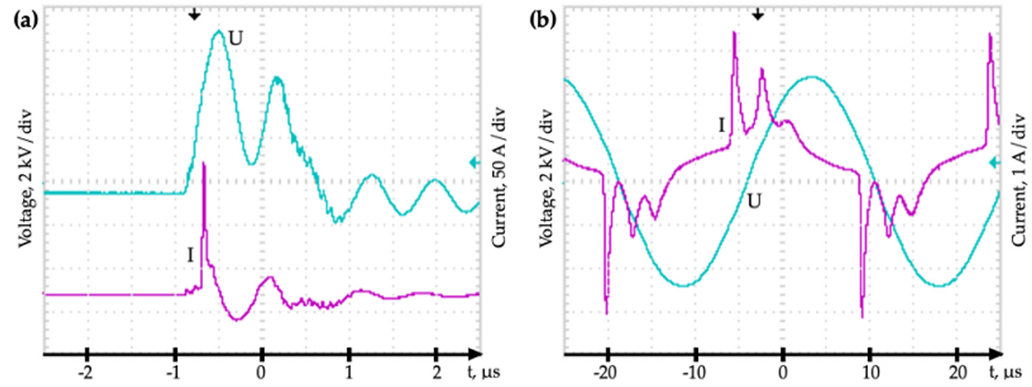
) and sine ( ∆ ) excitation voltage. (cid:35)